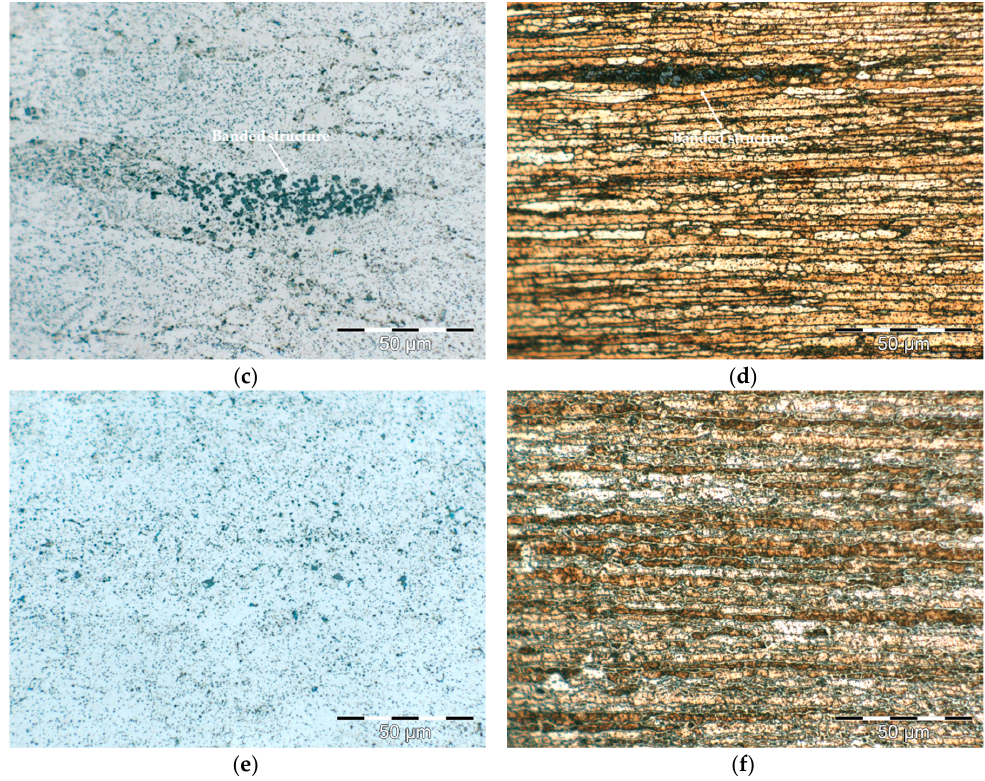
Figure 2. Light optical microscopy (LOM) micrographs of the longitudinal sections showing the microstructure of extruded profiles at preheating temperatures of 450 °C ( a , b ), 480 °C ( c , d ), and 500 °C ( e , f ) from AA 6005A powders. Images on the left: 10% NaOH reagent, images on the right: 10% NaOH and Weck’s reagent.